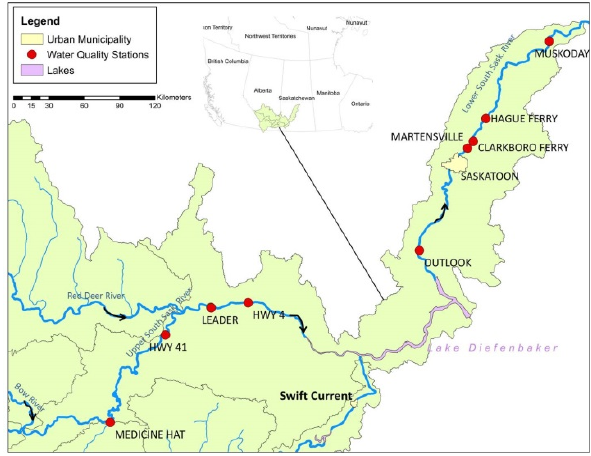
Figure 1 . Map of South Saskatchewan River Basin.